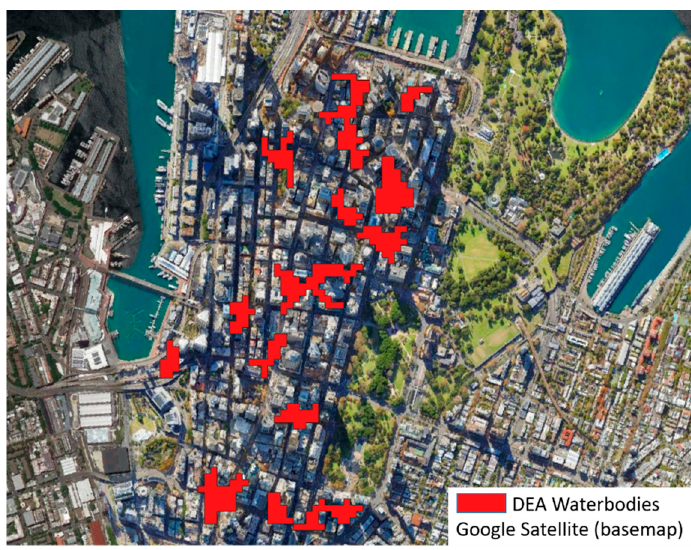
Figure A5. Incorrectly identified waterbodies within the Sydney